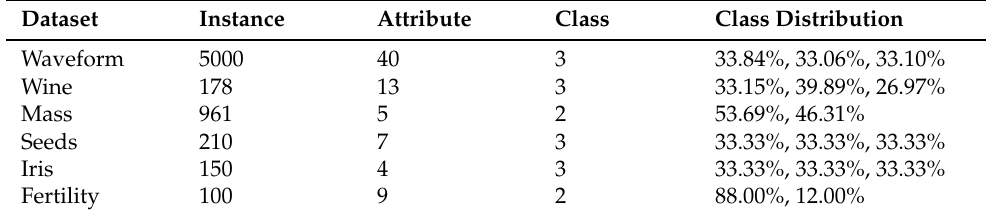
Table 4. Description of numerical